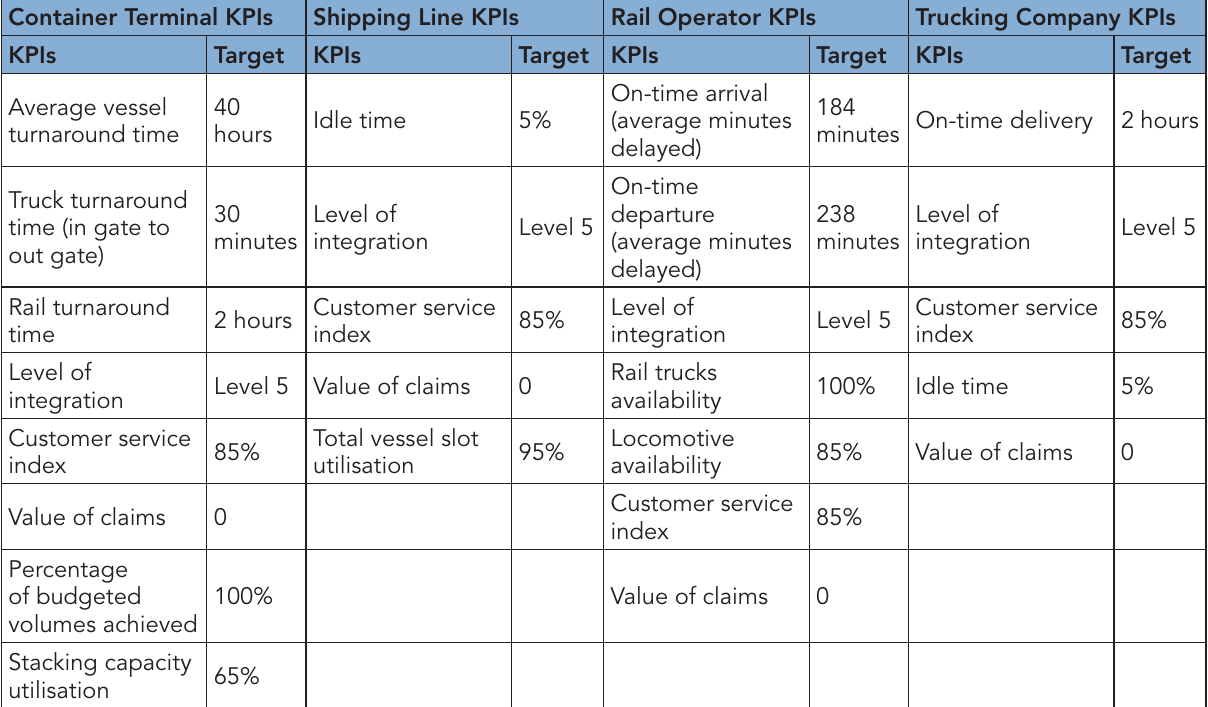
Table 1: Popular and possible KPIs for the PMS derived by management Container Terminal